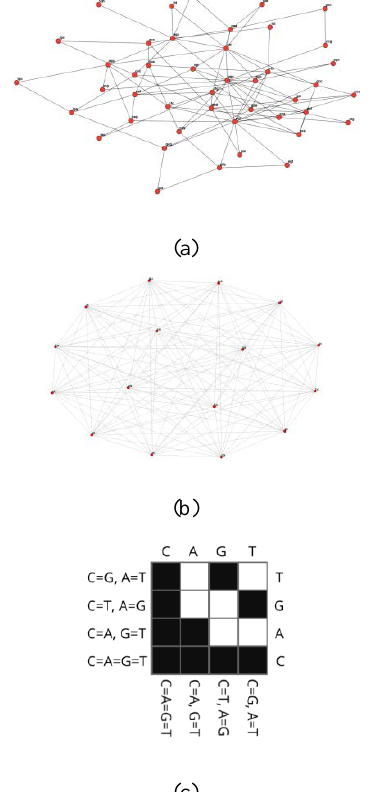
Fig. 1. Semantic network of the insulin gene when breaking the coding nucleotide sequence into blocks of 3 (a) and 2 (b) nucleotides. Hadamard matrix (c) representing the encoding of nucleotide sub-alphabets. Shaded cells +1, white cells -1 (or vice versa, depending on the encoding